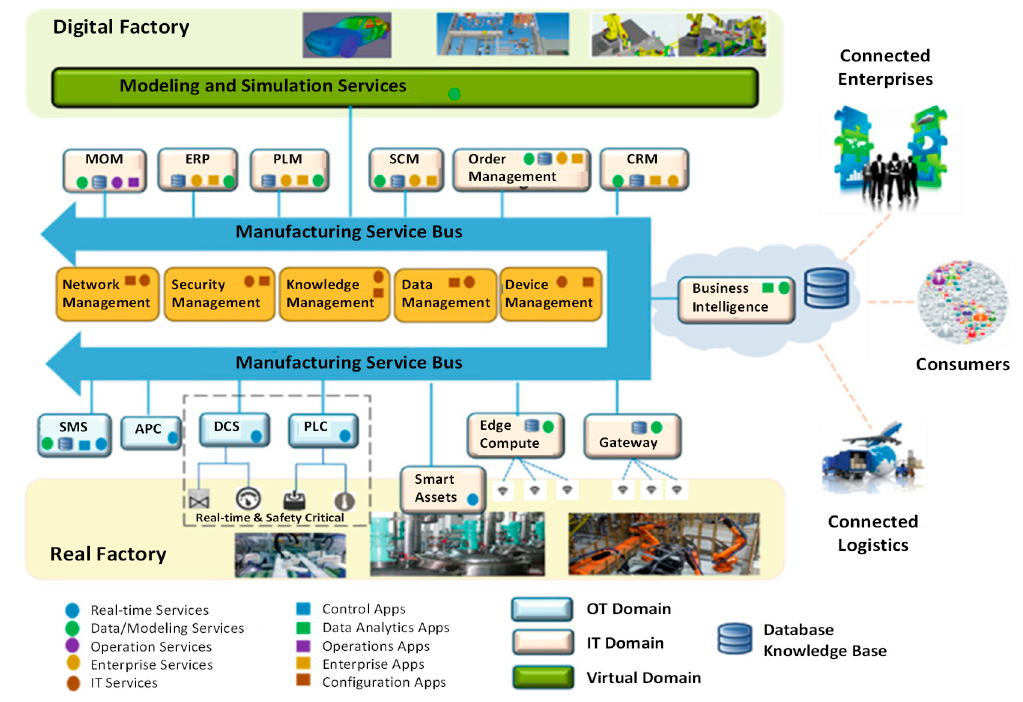
Figure 5. NIST service-oriented architecture for smart manufacturing working on a shared manufacturing bus (Reprint from [53]).